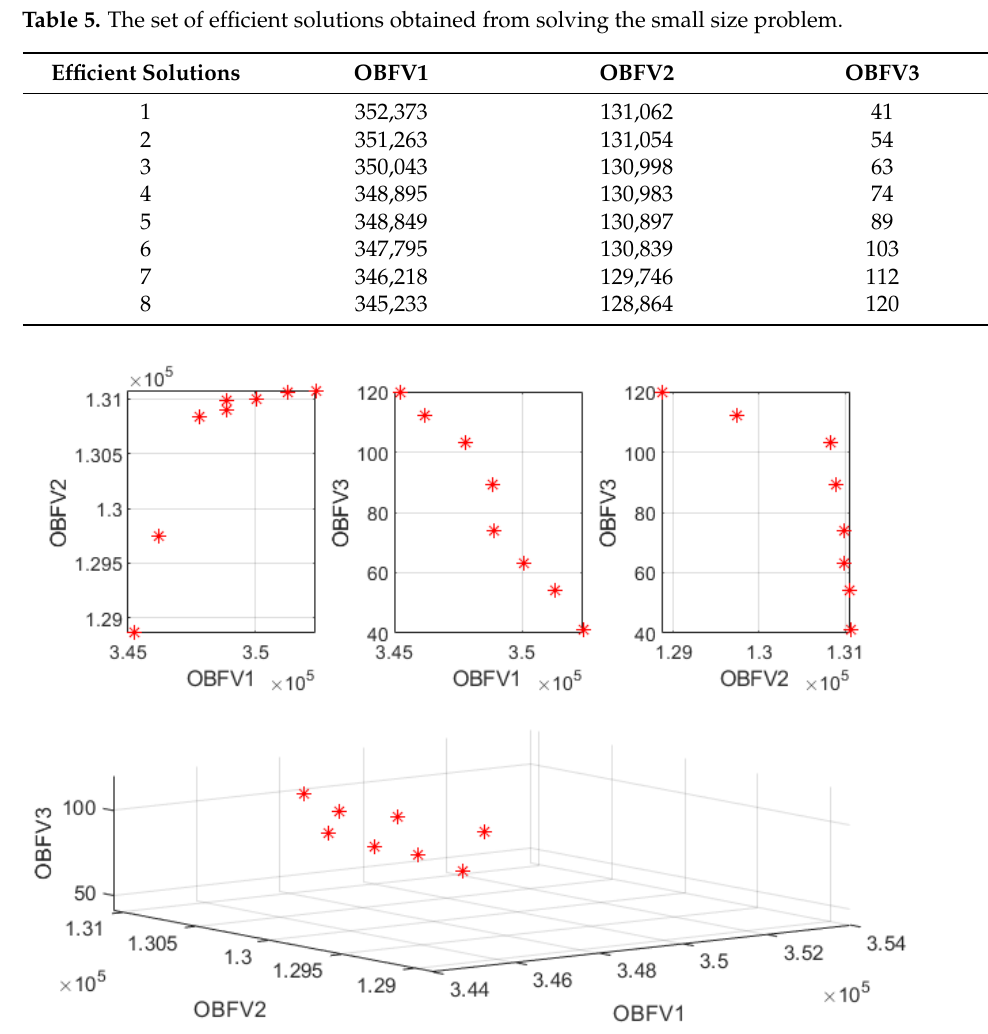
Figure 5. Pareto front obtained from solving the small size problem.